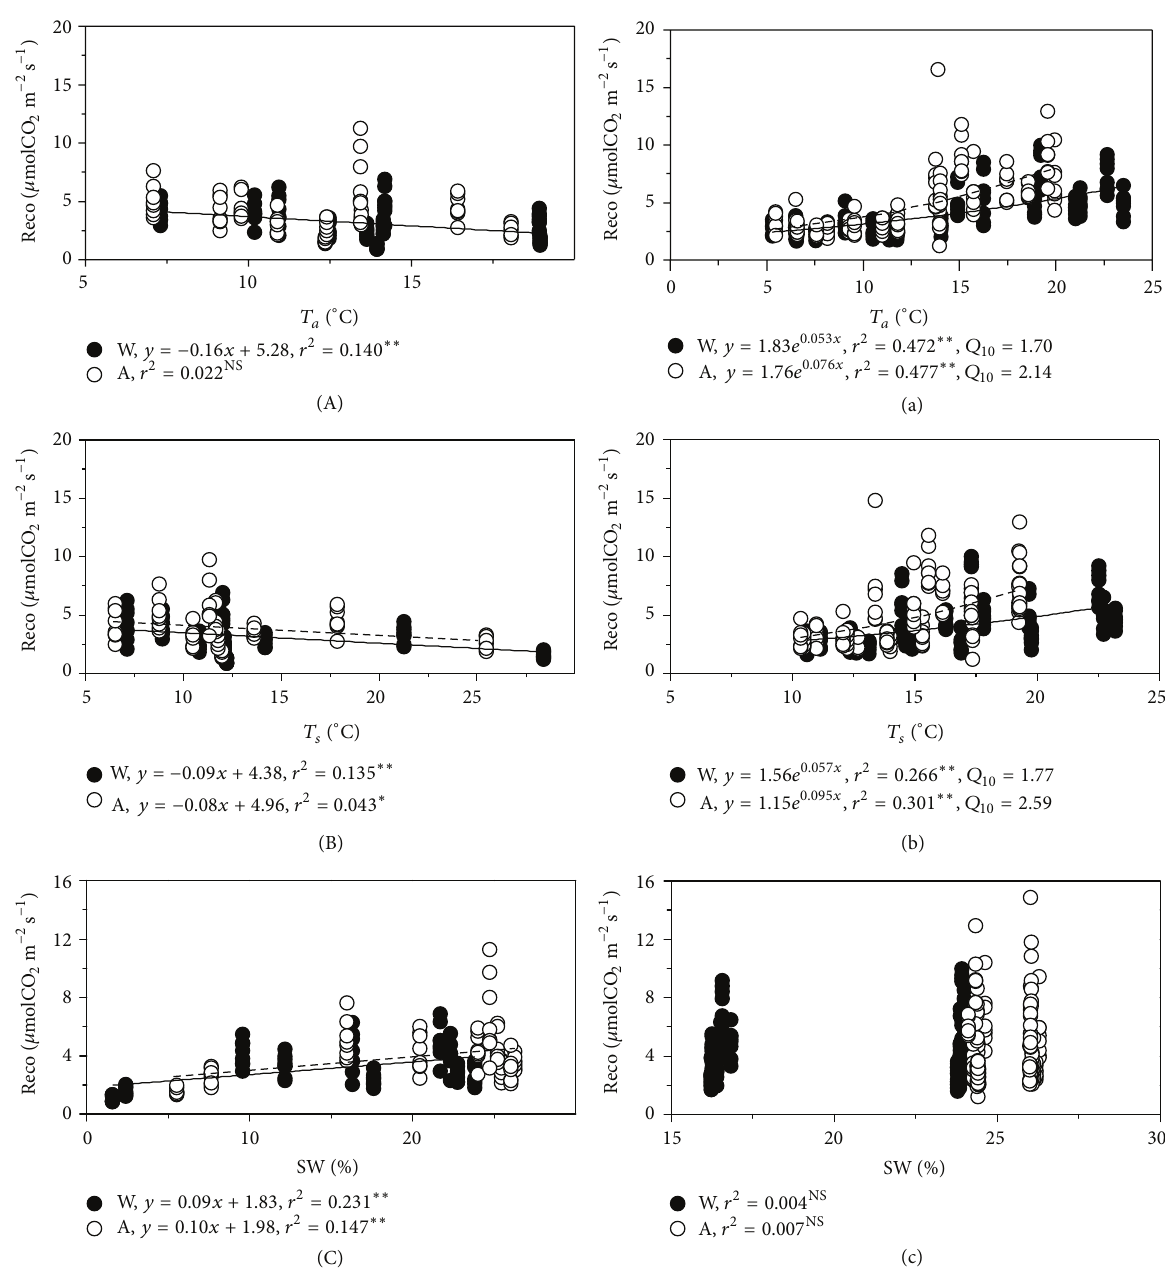
10 represents the sensitivity